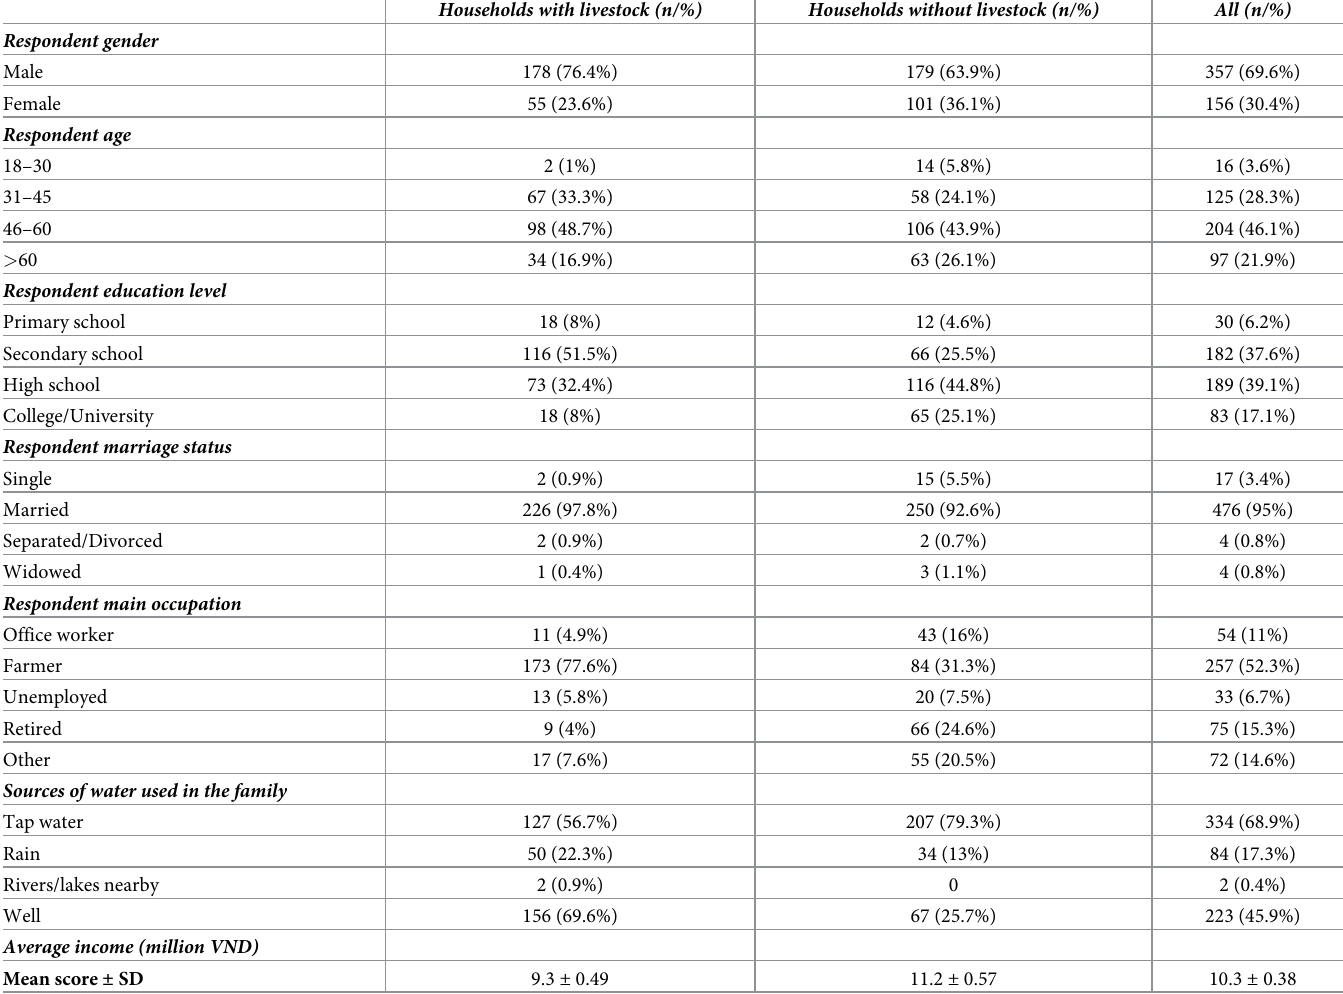
Table 1. Socio-demographic characteristics of the participating households with and without livestock in Hanoi, Vietnam. Households with livestock